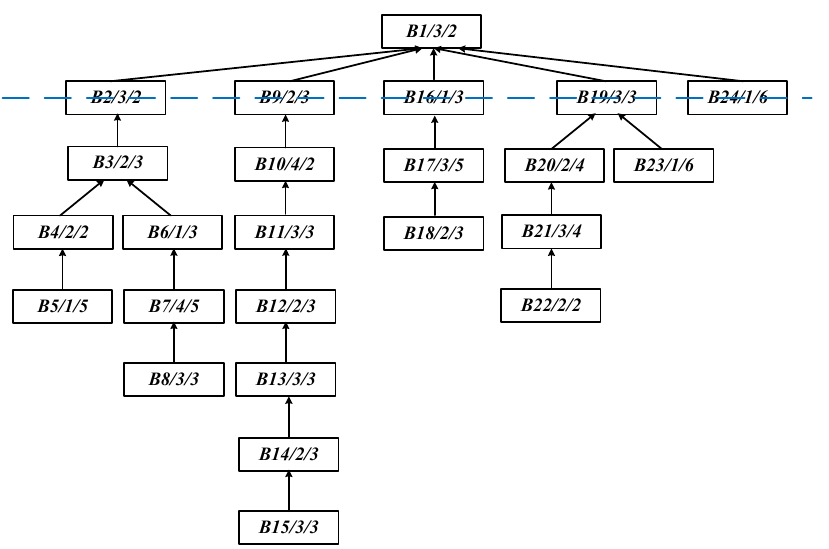
Figure 9. The decomposition diagram of complex product B (Blue lines represent cut sets).